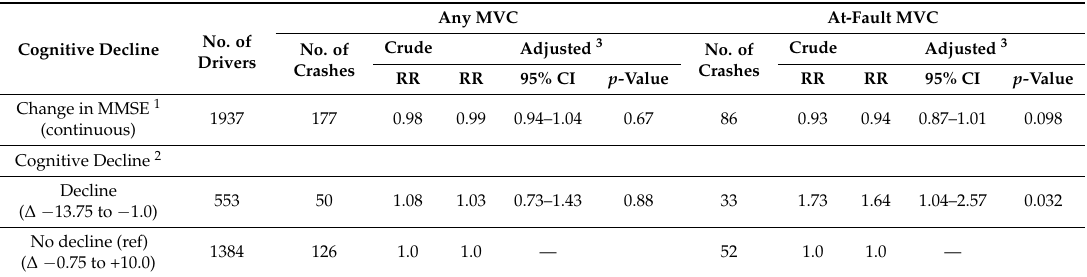
Table 3. Crude and adjusted association between cognitive decline from baseline to one-year follow-up and rate of future MVC involvement ( N =